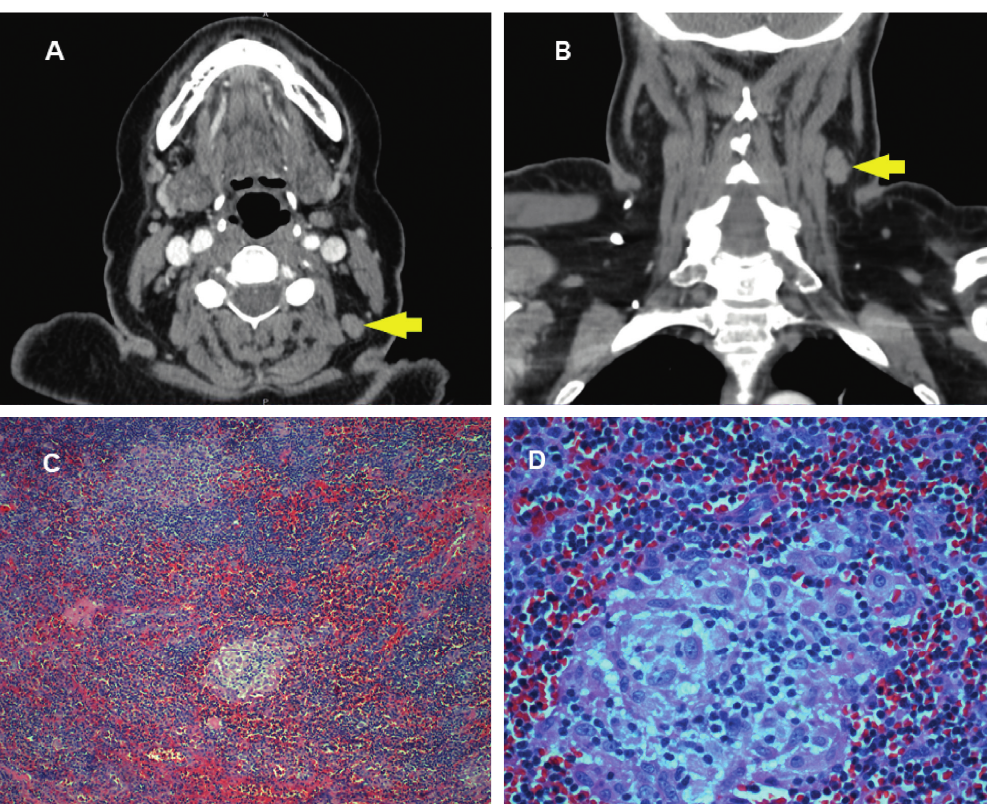
Figure 1: CTscan at transverse plane (a) and coronal plane (b) showing a 1.4cm left level 5A lymph node. No other adenopathy. No mass along the course of the aerodigestive tract. Cervical lymph node biopsy demonstrating lymph node with follicular hyperplasia, phagocytosis of nuclear debris, noncaseating epithelioid granuloma, and sinusoidal distension by plasma cells and immunoblasts (c) (x10 magnification). Higher magnification of the epithelioid granulomas (d) (x40 magnification).